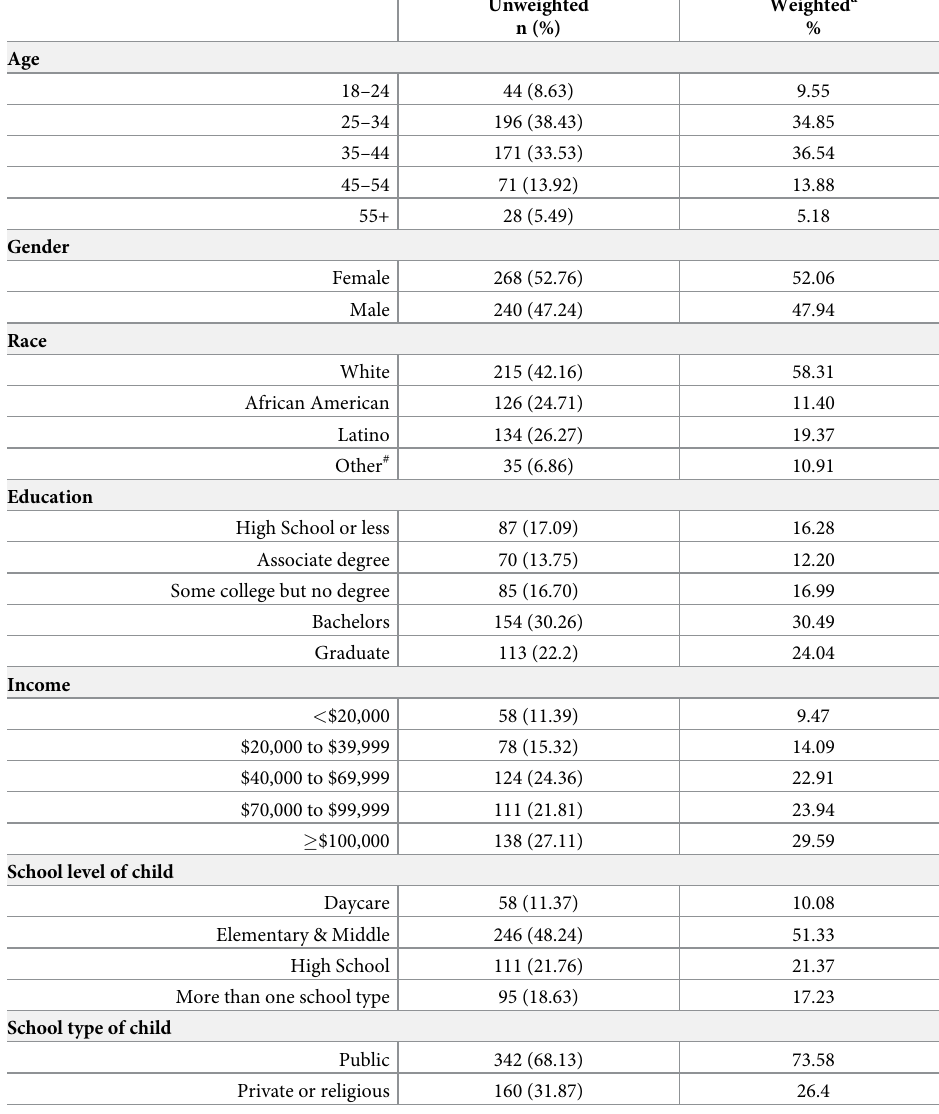
Table 1. Demographic and socioeconomic characteristics for respondents who self-reported being parents of kin- dergarteners and school-aged children (N = 510).